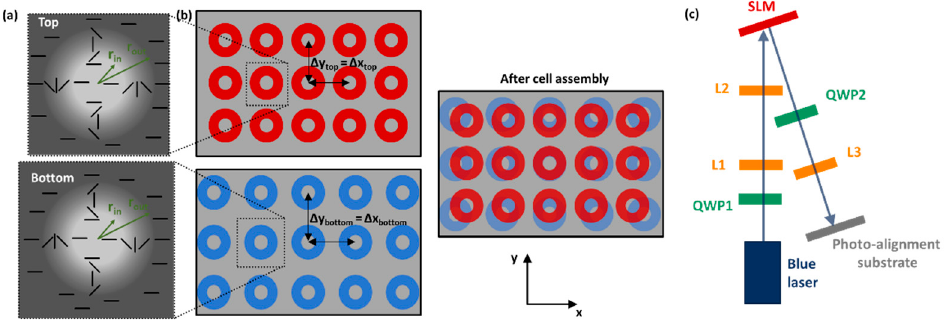
Figure 1. Schematic overview of the alignment patterns on top and bottom substrate ( a , b ) and the SLM based photo-alignment setup ( c ). Note that the top substrate has been flipped around the y axis after illumination (the top view of the alignment in the assembled cell is shown in ( a )). The alignment patterns at the top and bottom substrate have the same ring dimensions (r in , r out ) but different spacings Δ x, Δ y between the rings (with Δ x top < Δ x bottom ) as illustrated in ( b ). In the illumination setup two quarter wave plates (QWP 1—QWP2) and three lenses (L1–L3) are used.